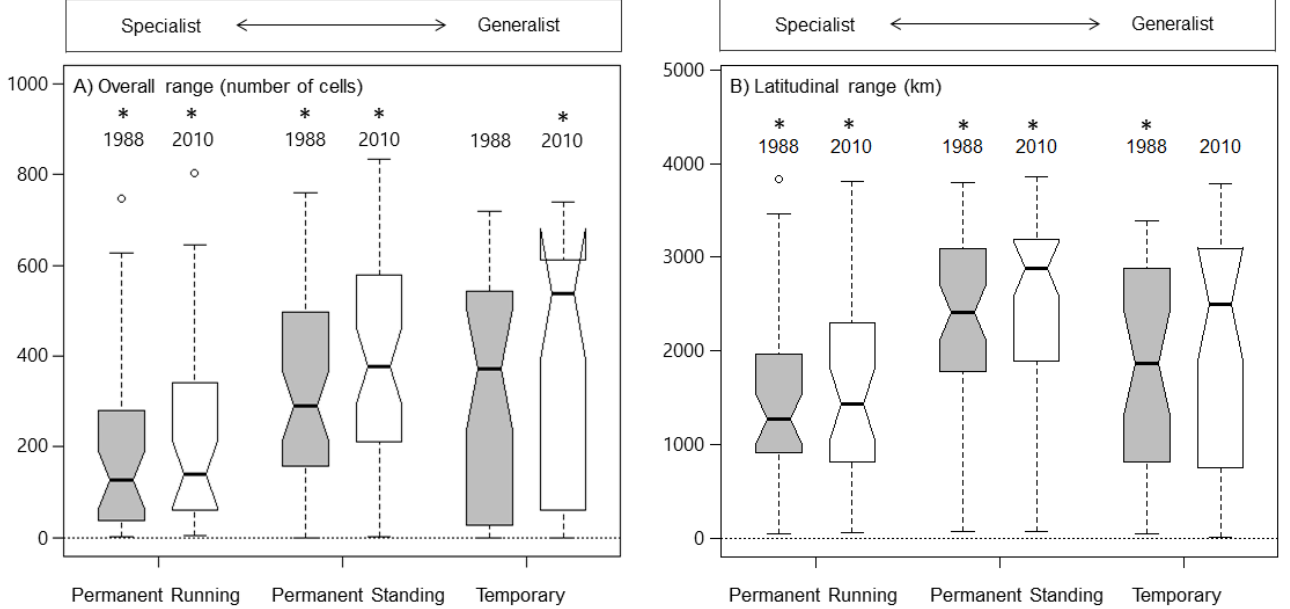
Figure 3. Range sizes in European dragonfly (Odonata) species adapted to permanent running (perennial lotic) water, permanent standing (perennial lentic) water, and temporary (running and standing) water habitats in 1988 (grey) and 2010 (white), respectively, with overall range size expressed as number of occupied 100 × 100 km grid cells, and latitudinal range expressed as the latitudinal extent of distributional range between northern and southern range borders separated by habitat utilization. The box-and-whisker plots illustrate the spread and skewness of the data through their quartiles. The whiskers extending from the box show data variability outside the upper and lower quartiles. Outlier points that differ significantly from the rest of the dataset are plotted as individual points (empty circles) beyond the whiskers. The box notches narrows around the median (thick black middle line) and offers a visual guide on the significance of the difference of medians; if the notches of two boxes do not overlap, this will provide evidence of a statistically significant difference between the medians. Significant variables at α = 0.05 in the within-year analysis of differences in overall range size and latitudinal range of the three unmatched test groups—permanent running water, permanent standing water, and temporary (running or standing) water—are indicated with *. Top scale represents a gradient going from habitat specialist with a narrow niche breadth to habitat generalist with broad niche breadth.